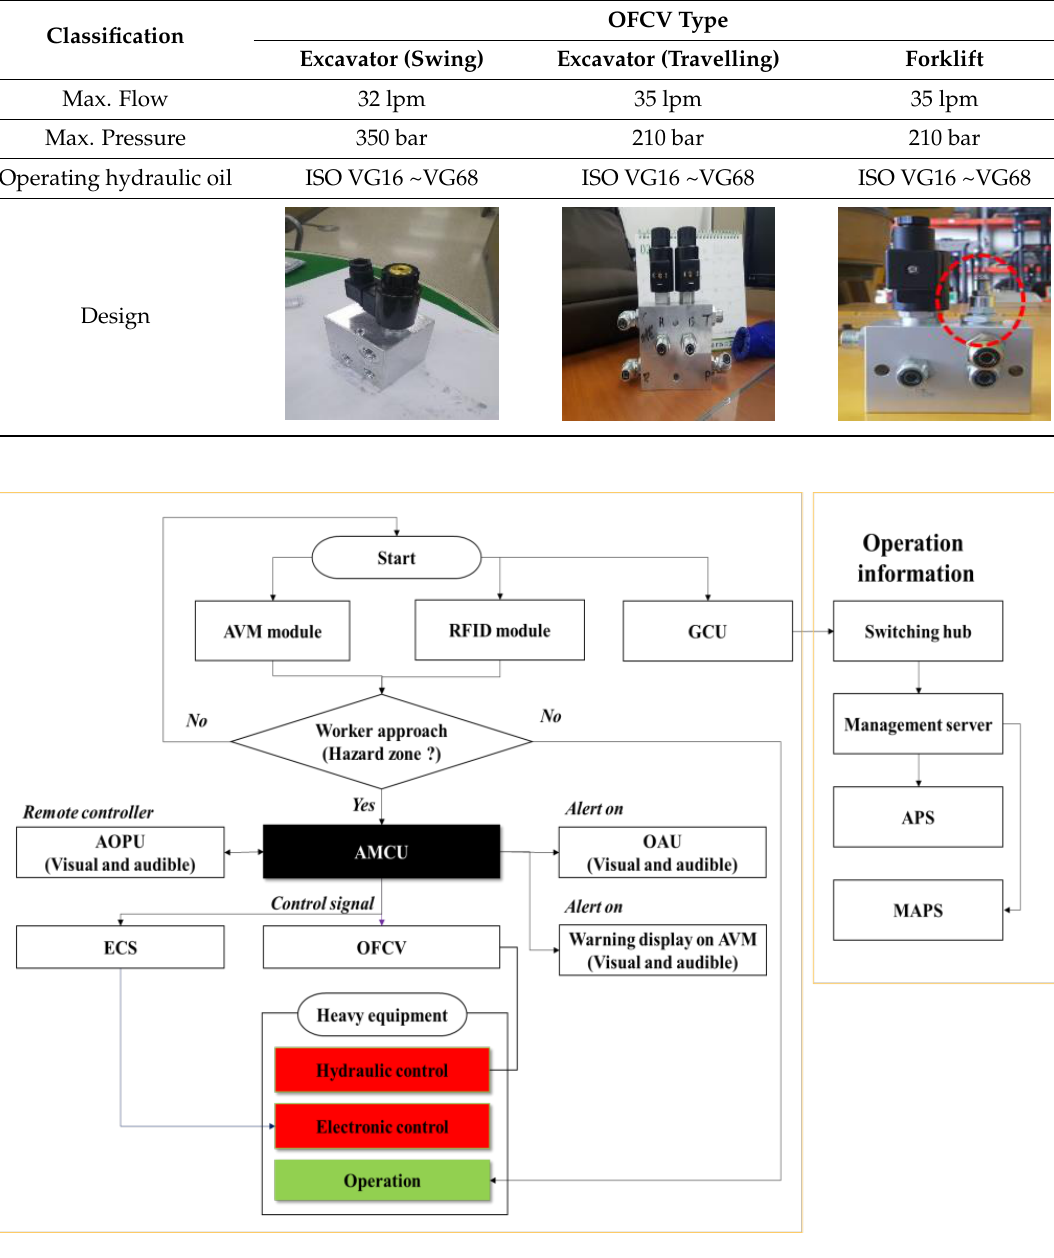
Table 6. Oil follow control valves (OFCVs) of three type specifications for hydraulic machine control. Classification